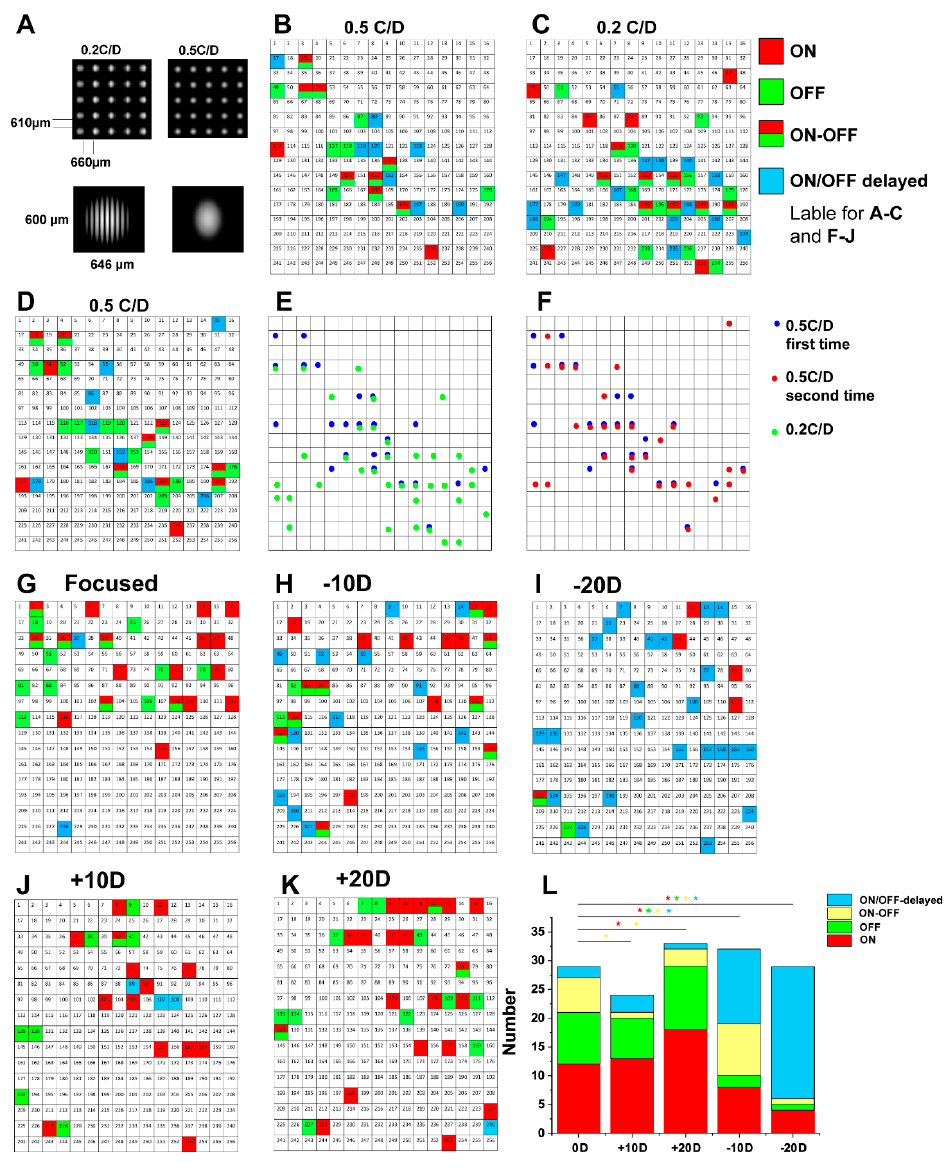
Figure 2. RGC firing responses to different defocused images on MEA recording: Firing pattern recorded from MEA can reflect the image projected on the mouse retina. First, 5 × 5 images (diameter 0.6 mm (height) × 0.646 mm (width), 0.5 cycle/degree (light intensity 7.4 × 10 4 Rh*/rod/sec); stimuli time 1 s in 6-s circle for 10 min; there were more stripes compared with 0.2 C/D) were projected ( A ). Different colors labeled the ON, OFF, ON–OFF and ON/OFF-delayed cell responses at the position of MEA arrays and were mapped (B) . The map of the firing pattern changed after image stimulation switch to 0.2 C/D (light intensity 9.1 × 10 4 Rh*/rod/sec) (C ). Merging these two maps showed the co- localization of cells’ responses (E). Only 30% of cells had responses at the same position. Then, the same 0.5 C/D image stimulation was projected again onto the retina (D) . For the same position of the first 0.5 C/D projection, 50% of cells had responses. The firing pattern was similar to the former 0.5 C/D image projection (F) . From Figure 2G–K, the images were programmed with diameter of 1.804 mm; 0.2 C/D, square-wave grating; light intensities varied from 1.5 × 10 5 Rh*/rod/sec to 1.1 × 10 5 Rh*/rod/sec under defocus. Firing patterns of RGCs or dACs in the mouse retina changed among the